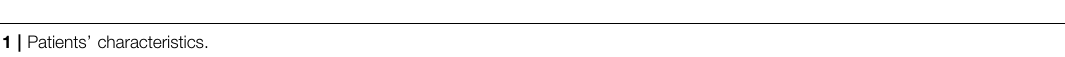
TABLE 1 | Patients ’